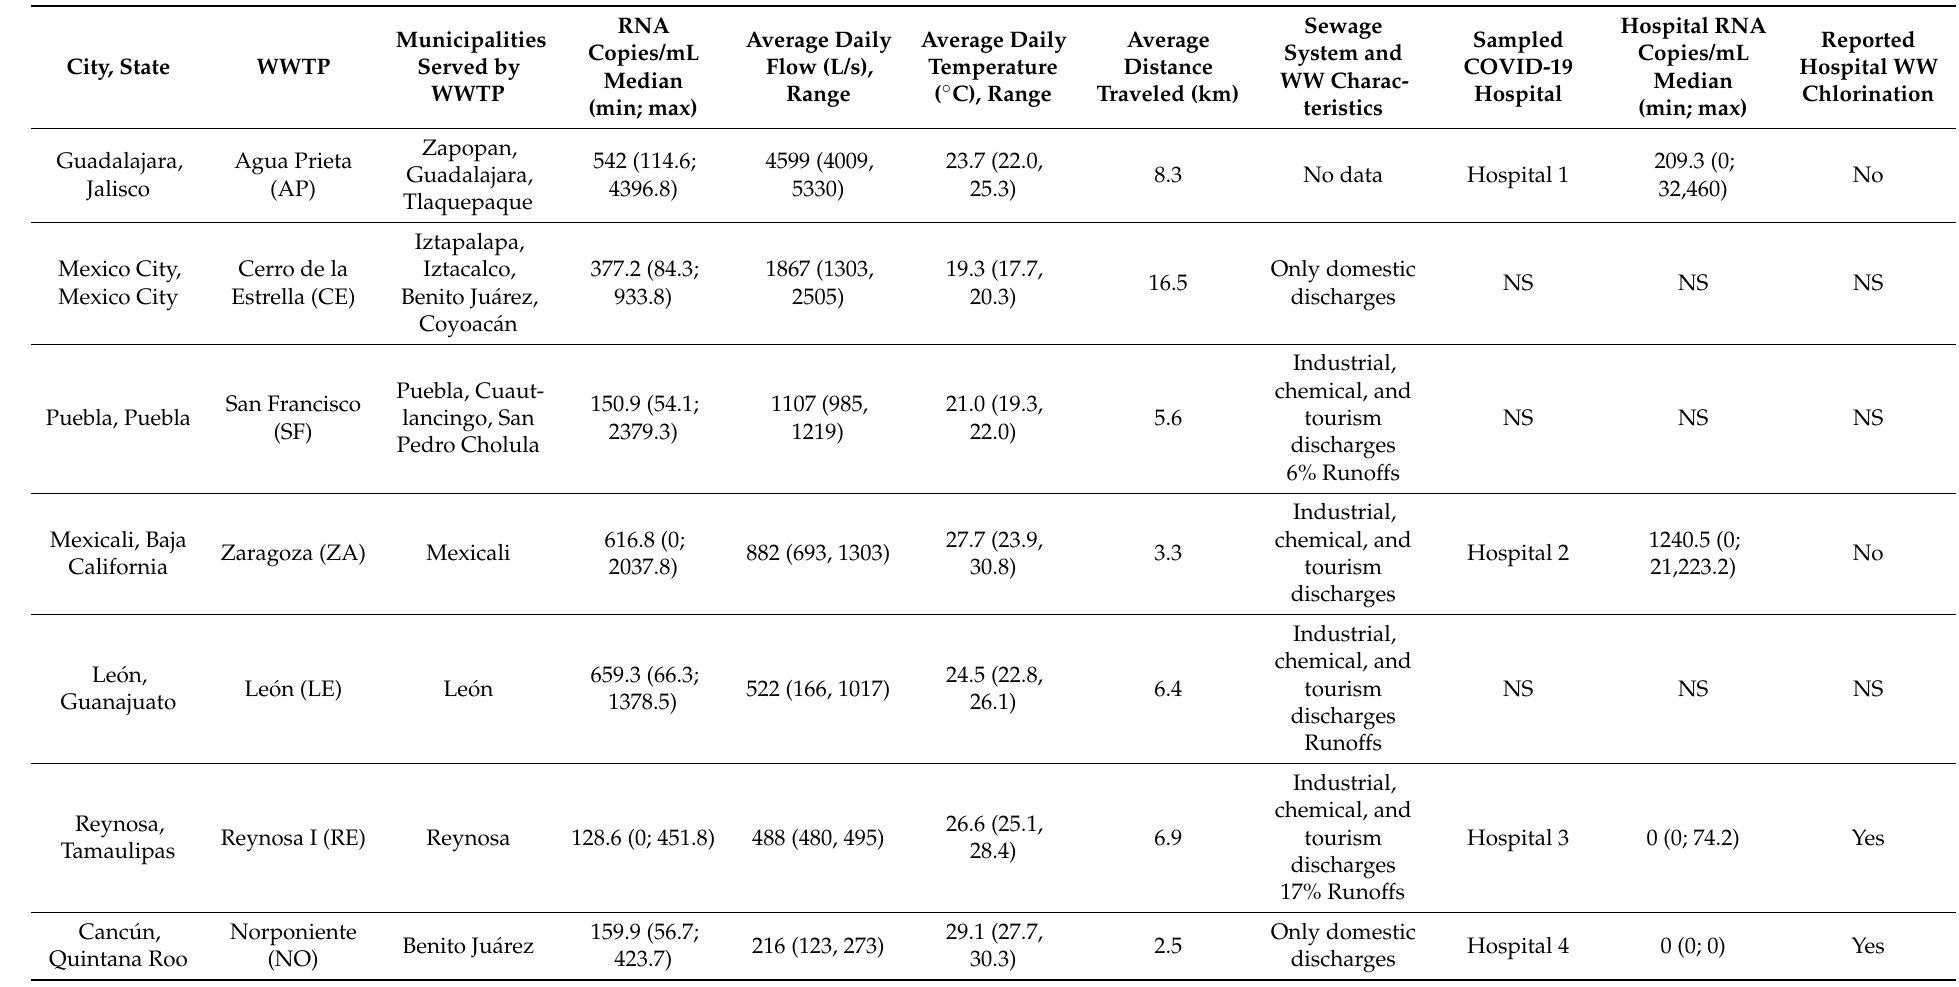
Table 1. SARS-CoV-2 quantification in wastewater, average measurements, and basic characteristics of sampled WWTP and COVID-19 hospitals from 10